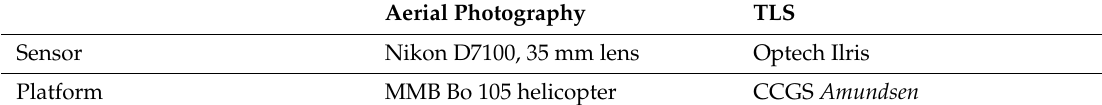
Table 2. Aerial photography and terrestrial laser scanning (TLS) survey equipment specifications. Aerial